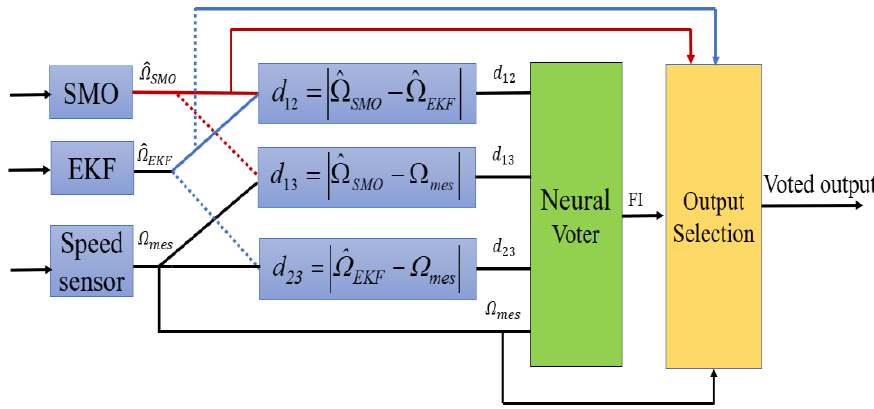
Figure 8. Structure of the Neural Voter Algorithm.